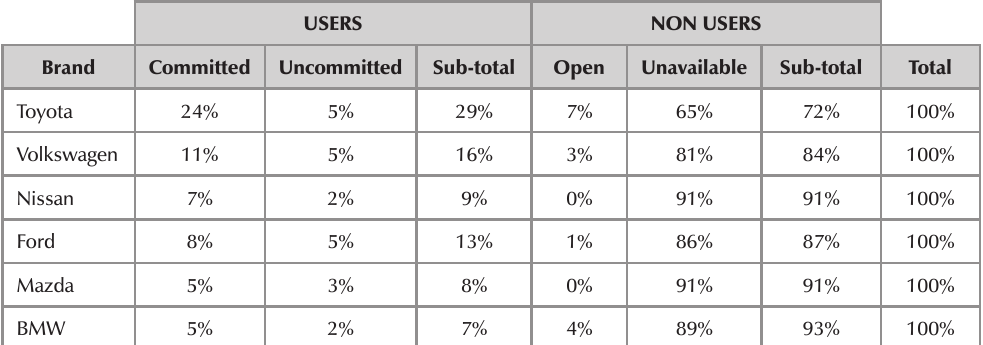
Percentage of consumers in the different CM segments USERS NON